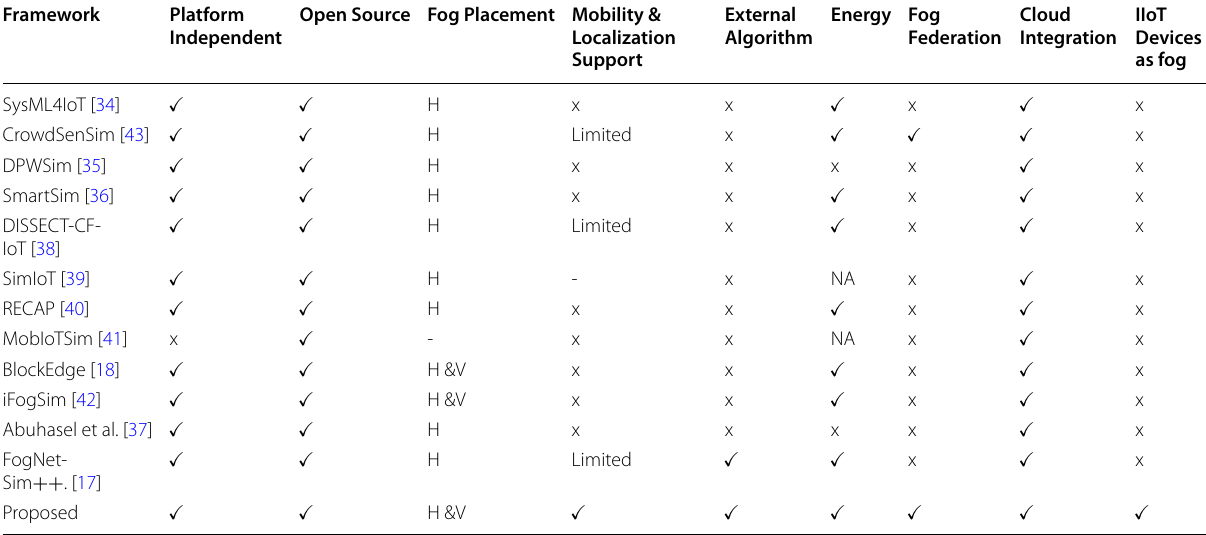
H horizontal or distributed, V vertical or hierarchical